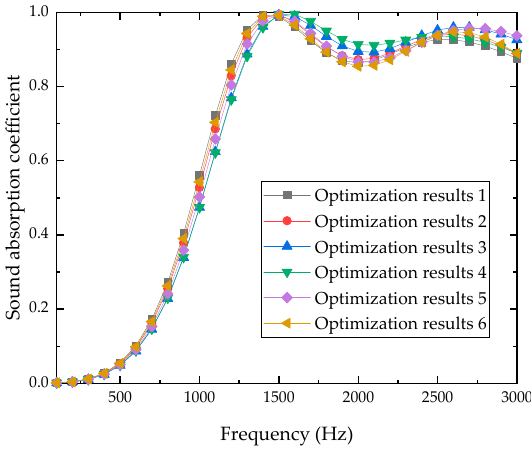
Figure 13. Optimized results (optimization goals are constrained).